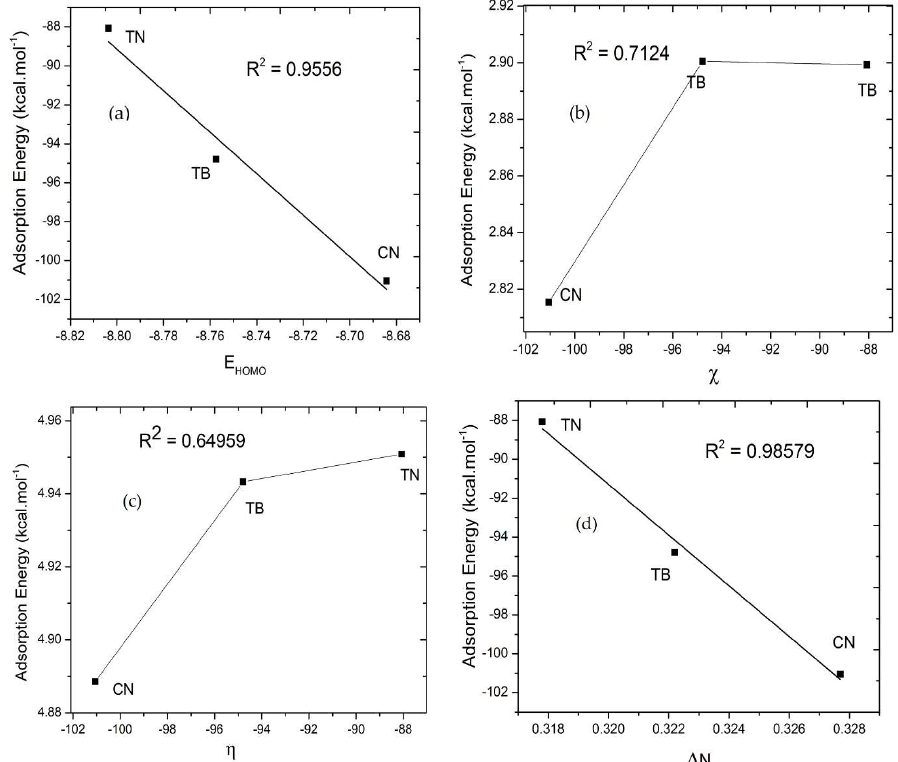
Figure 5. Correlation of the adsorption energy and quantum parameters such as EHOMO, electronegativity, hardness, and electron transfer of neutral inhibitors (caffeine (CN), theophylline (TP), and theobromine (TB)) in copper surface. ( a ) The correlation between the adsorption energy and EHOMO, ( b ) the adsorption energy and electronegativity, ( c ) the adsorption energy and hardness, ( d ) the adsorption energy and electron transfer.